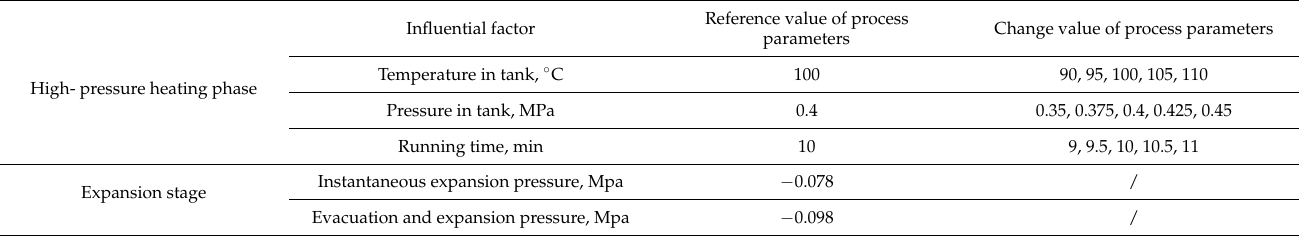
Table 1. Change value of process parameters at each